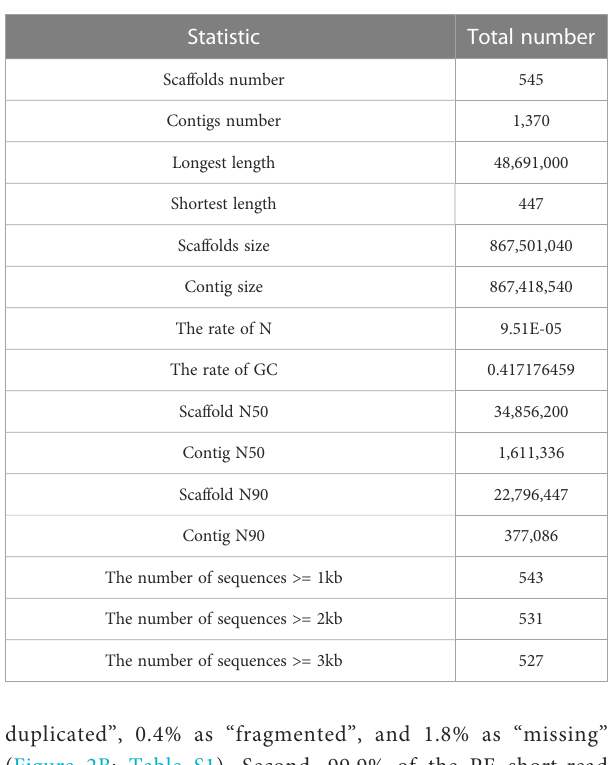
TABLE 2 Statistics of the O. cubicus genome assembly.